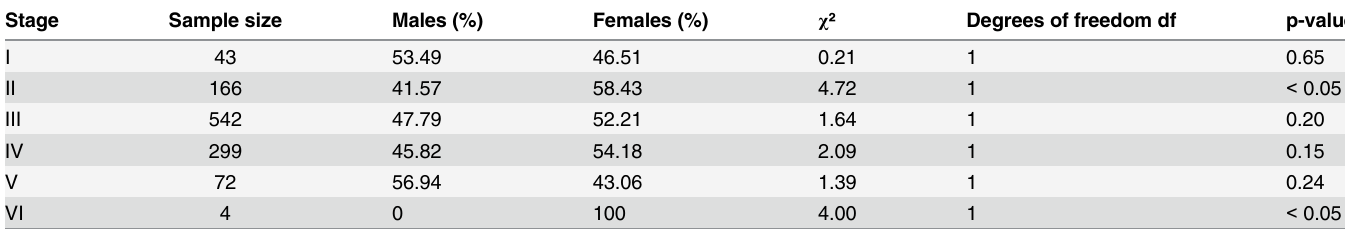
Table 4. The proportions of male and female Sardinella maderensis individuals at the different sexual maturity stages. Stage Sample size Males